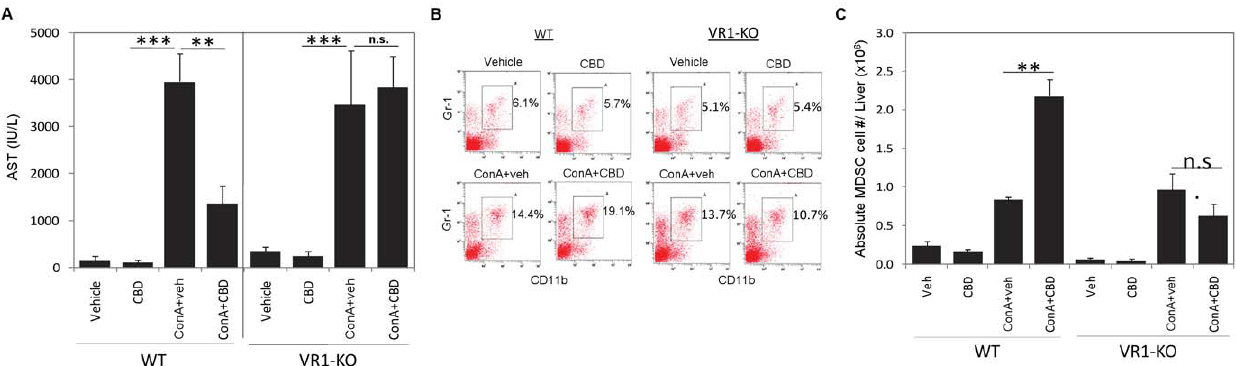
Figure 6. Role of TRPV1 (vanilloid) receptors. WT or TRPV1 vanilloid receptor knockout (VR1-KO) mice were injected with vehicle, CBD, ConA + veh or ConA + CBD. A) After 16 h, blood was collected and serum AST levels were measured. B) Liver infiltrating leukocytes were stained and analyzed for CD11b + Gr-1 + MDSCs by FACS. Representative dot plots with percentage of MDSCs shown (gated). C) Absolute number of MDSCs in the liver of WT and VR1-KO mice. Data are mean 6 SEM with 4 mice per treatment. **p , 0.01, ***p , 0.001, n.s. (not significant) based on Student’s t -test.